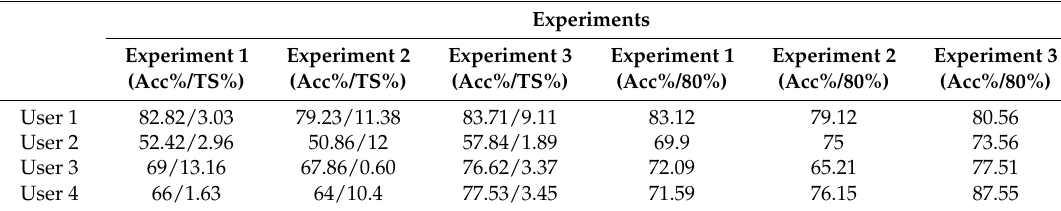
Table 3. Classification performance obtained from 3-axial acceleration sensors.